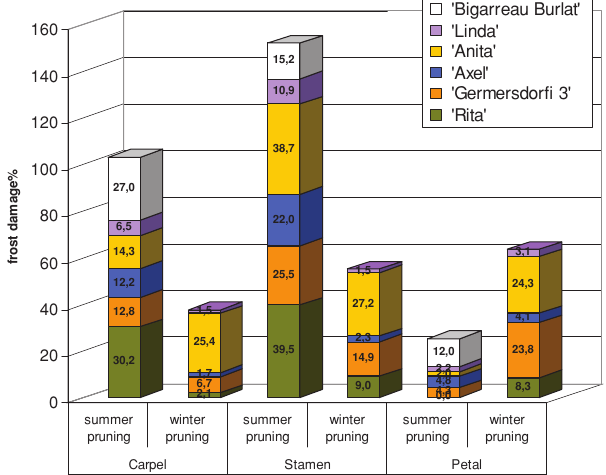
Figure 2. The effect of pruning policies on the length of spurs developed on different ages of wood (Debrecen–Pallag, 2009)